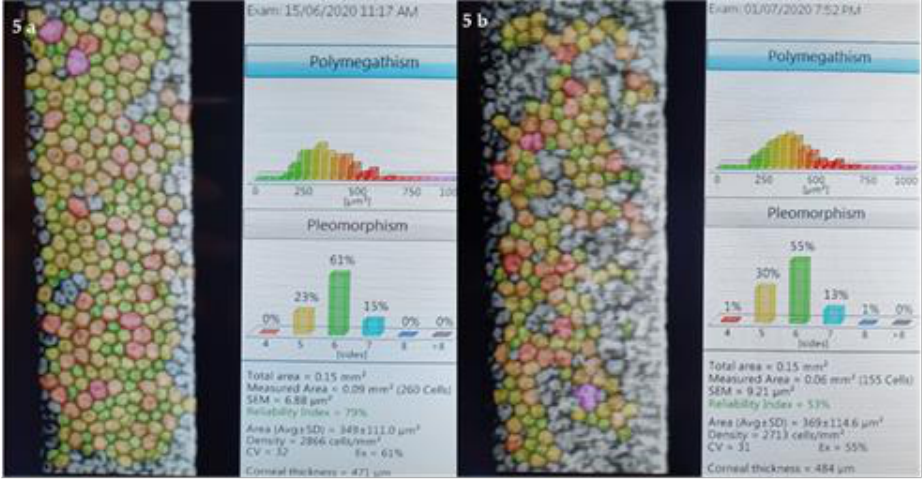
month was 2252 cells/mm 2 on average (range 1987–2497 cells/mm 2 ) and 2316 cells/mm 2 on average (range 2089–2599 cells/mm 2 ) at 1 and 6th postoperative month, respectively, see Figure 5a,b and Table 3.